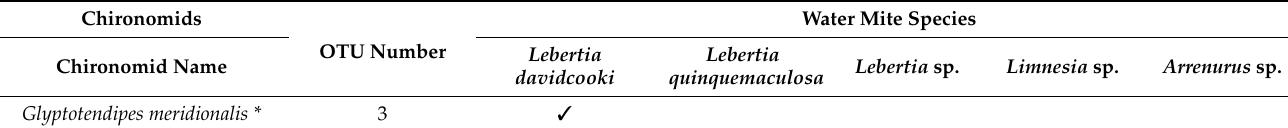
Figure 6. Water mite chironomid diet improvements from curated chironomid database. Improve- ments from family to genus (green circle), genus to species (blue circle) and family to species (red circle) are represented. The numbers in the diagram refer to specific mites in the water mite database for this project. Table 4. Chironomids that were observed as prey in Lebertia davidcooki , Lebertia quinquemaculosa , Lebertia sp., Limnesia sp. and Arrenurus sp. indicated by check marks. Identifications that are between 3.5% and 9.5% pairwise difference from the mite diet sequence or that are identified as no better than to genus are marked with an